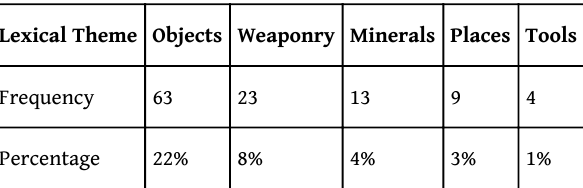
Lexical Theme Objects Weaponry Minerals Places